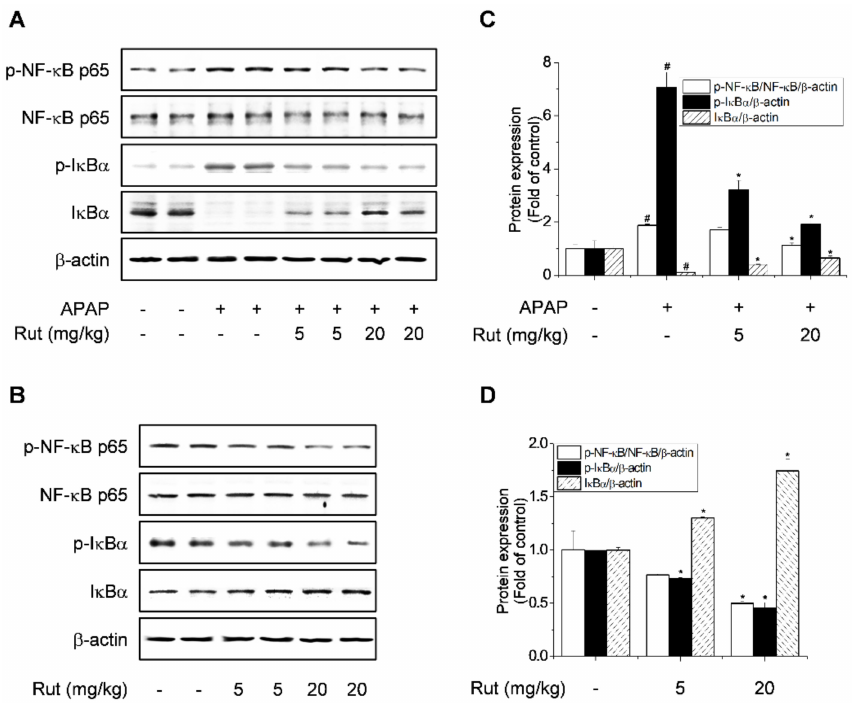
Figure 4. Protective effect of Rut on APAP-induced NF- κ B activation in mice. Hepatic protein levels of phospho-NF- κ B p65, NF- κ B p65, phospho-I κ B α , and I κ B α were determined using western blotting ( A , B ). Protein level was analyzed using ImageJ software. Relative expression of the target protein was compared using β -actin as a control. ( C , D ) are indicated as means ± SD ( n = 10). # Significantly different from the control ( p < 0.05). * Significantly different from the APAP-treated group ( p < 0.05). 3.3. Rut Pretreatment Prevented APAP-Reduced Antioxidant Enzymes by Activating